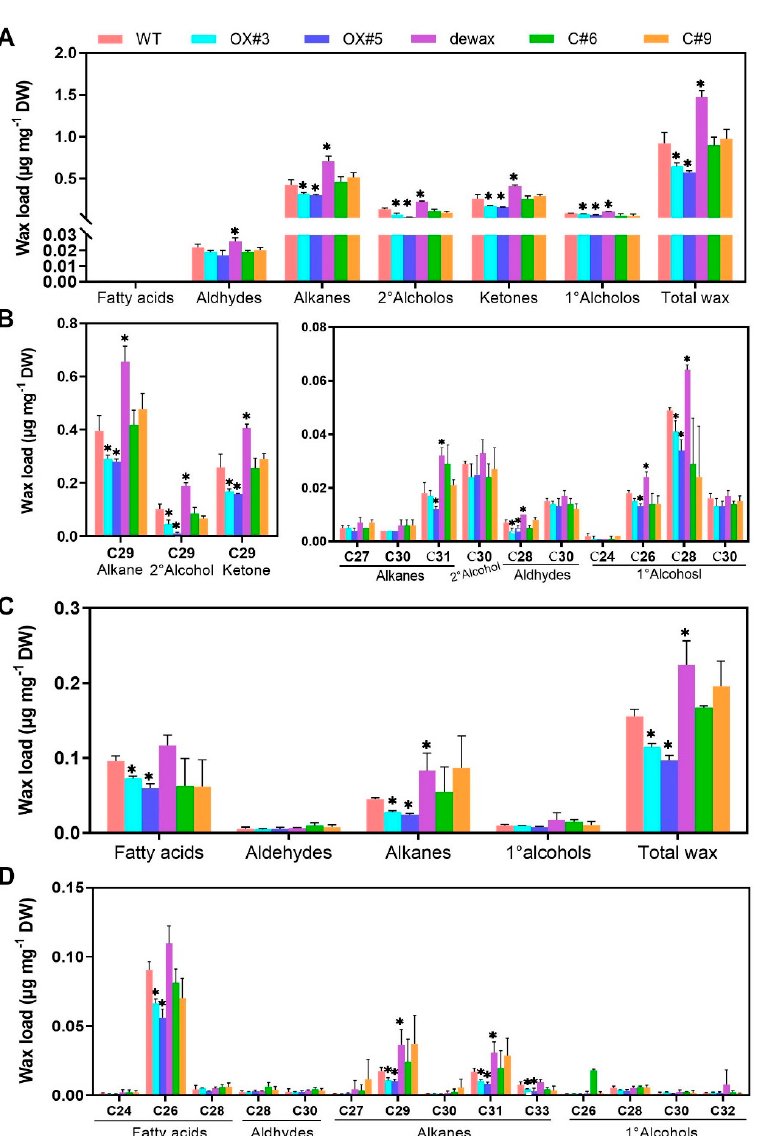
Figure 5. Cuticular wax analysis in Arabidopsis wild type and BnaC9.DEWAX1 overexpression and complementation lines. ( A ) Total wax coverage and amount of each wax class in stem. ( B ) Amounts of individual components in each wax class in stem. ( C ) Total wax coverage and amount of each wax class in leaf. ( D ) Amounts of individual components in each wax class in leaf. Cuticular waxes were extracted from six-week-old plants with chloroform and analyzed using gas chromatography. Error bars indicate ± SD from three biological replicates. Data were statistically analyzed using Student’s t -test (* p <